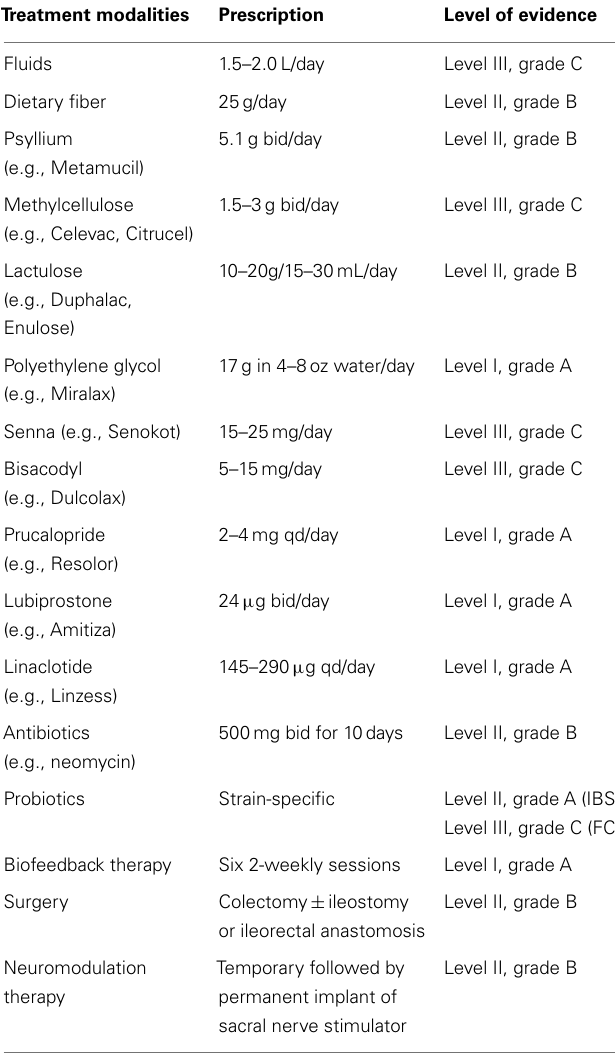
Table 1 | Evidence-based management of